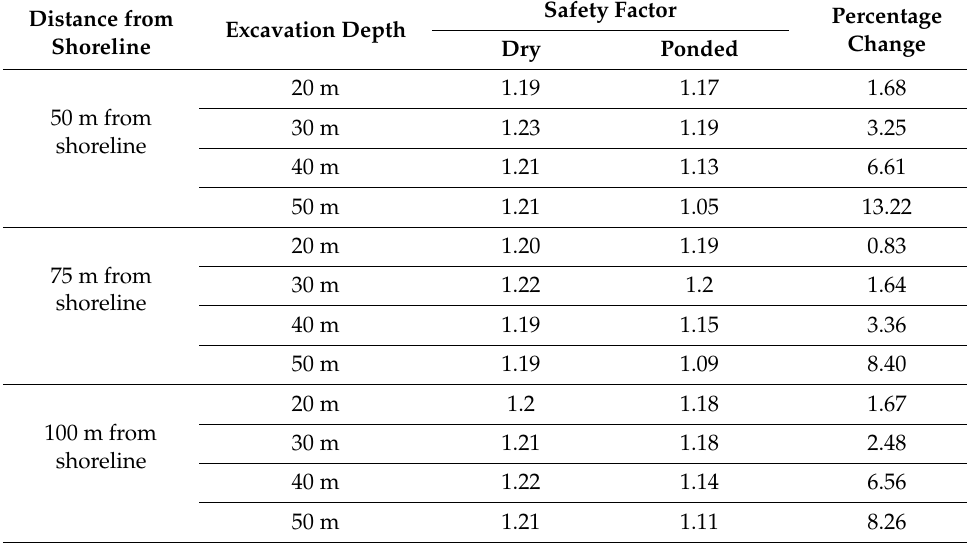
Table 3. Variation of slope safety factor due to